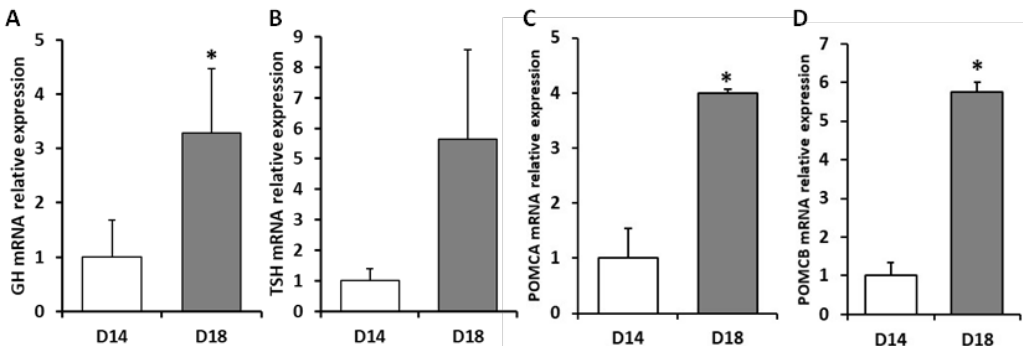
Figure 1. Relative gene expression of pituitary hormones of gilthead sea bream juveniles fed two dietary regimes for 35 days at 22 ◦ C. Data are shown as arbitrary units referred to relative expression for D14 as Mean ± Standard error of mean. Hormones analysed were: ( A ) Growth Hormone, GH; ( B ) Thyroid Stimulating Hormone, TSH; ( C , D ) Proopiomelanocorticotropin peptides A and B, POMCA and POMCB. * indicate significant di ff erences between D14 and D18 (Student’s t -test).